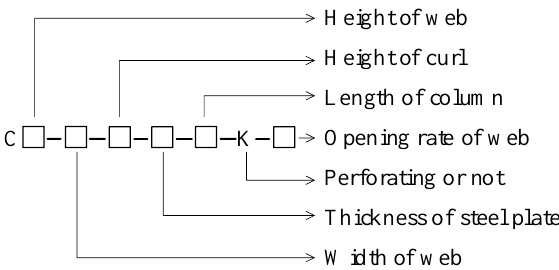
Figure 7. Naming rules of the combined columns in parametric analyses.